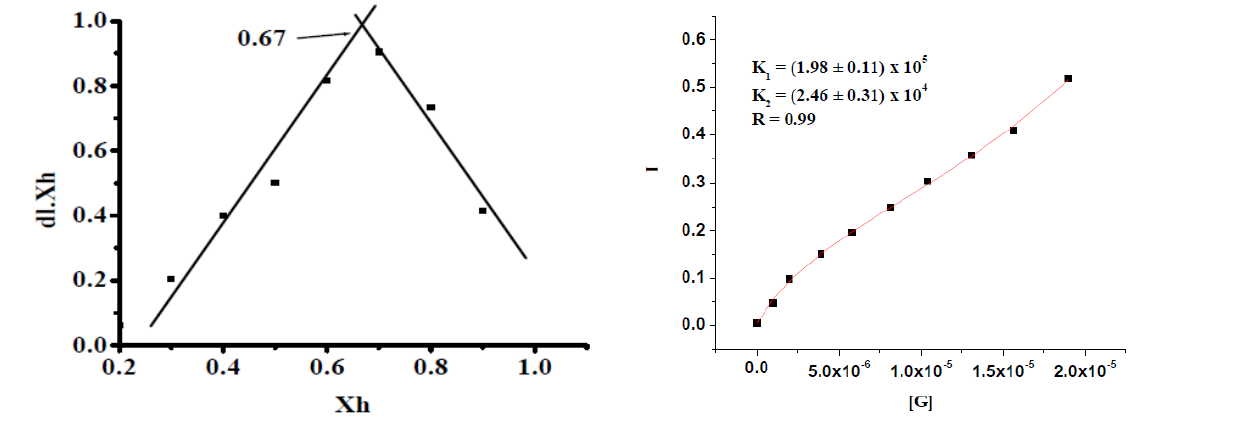
Figure 26: Jobs plot diagram of receptor R 34 for anion tetrabutylammonium acetate (where X h is the mole fraction of host and dI indicates the change of the absorbance).